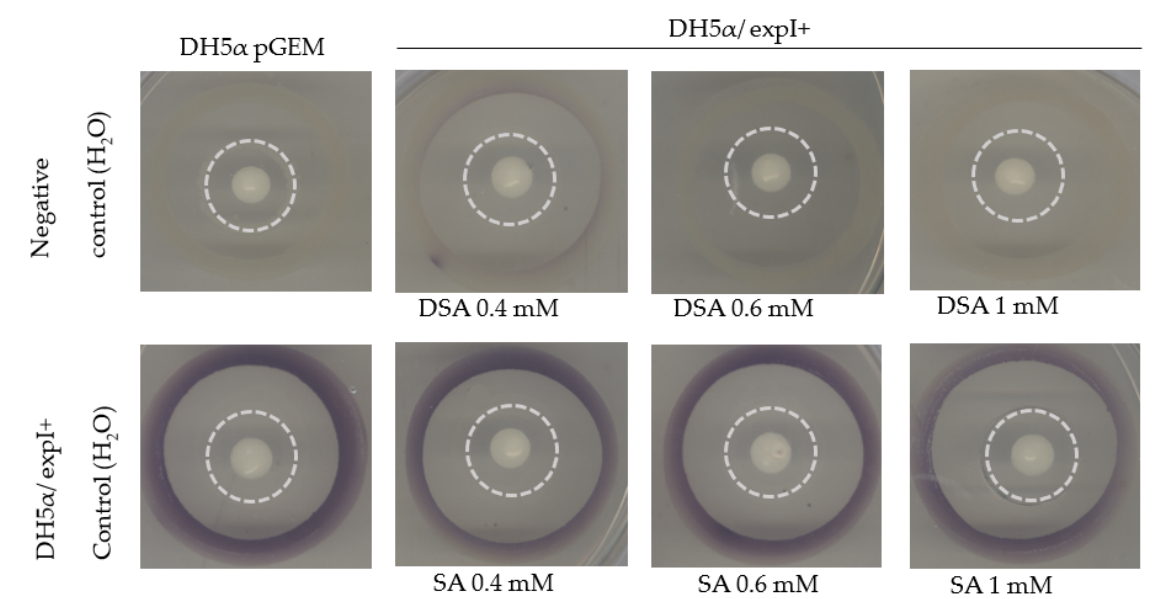
Figure 9. Effects of DSA and SA on the production of quorum sensing (QS)-signaling molecules (AHLs) by an Escherichia coli DH5 α QS negative strain complemented with expI from Pb1692. DH5 α / pGEM treated with dH 2 O was used as a negative control. The violet pigment (violacein) is formed by Chromobacterium violaceum CV026 in response to N-acyl-homoserine lactones (AHLs) produced by the DH5 α /expI+ strain, following exposure to non-inhibitory concentrations of DSA or SA, or DDW (control). The treatments (30 μ L) were applied to the central paper disc; the inner circle contained DH5 α /expI+ (or DH5 α /pGEM) and the outermost circle contained the reporter strain CV026.